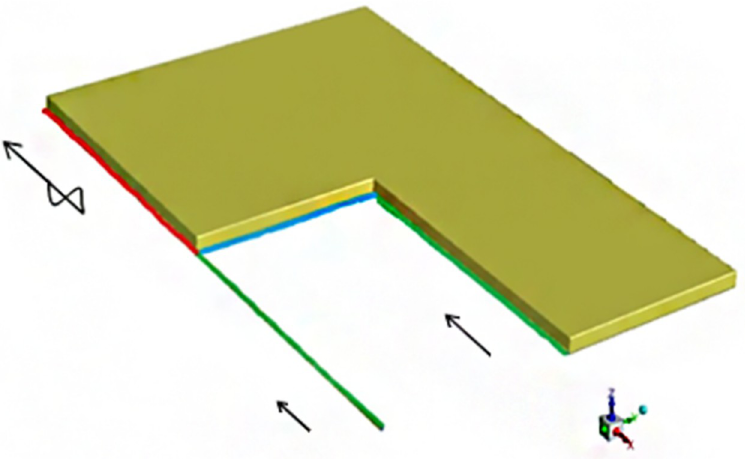
Fig 6. Model drawing of gob-side entry retaining goaf retention in Qipanjing Mine.